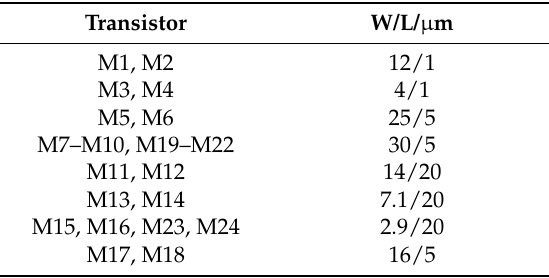
Figure 8. 12.5 nS transconductor used in Figure 7. A bias network (not shown) generates voltages V b 0 – V b 3 from a single input current. Table 4. Transistor sizes from Figure 8. All transistors are high threshold devices, apart